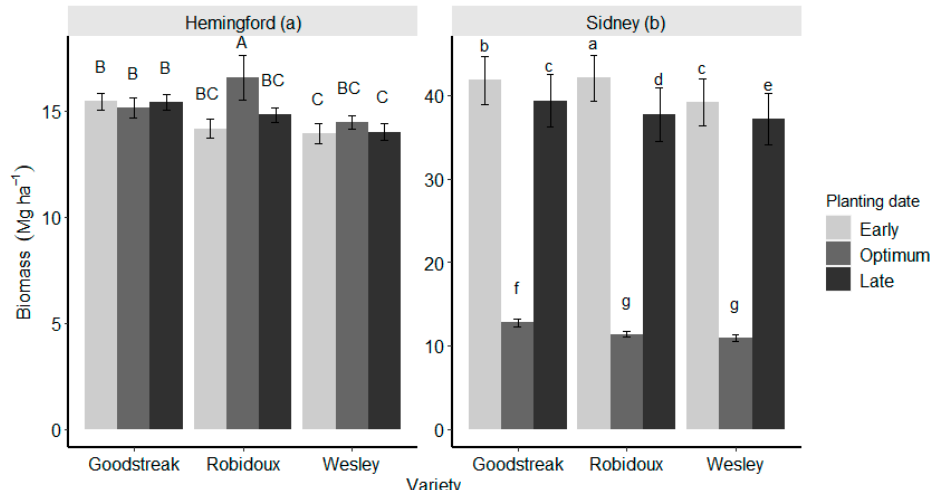
Figure 5. Influence of planting date × variety interaction on biomass at Hemingford and Sidney experimental sites. The error bars represent the standard error of the mean. Different letters on top of column bars of each panel indicate a significant mean difference at p < 0.05. Table 3. Means of main effects, showing significant differences where they exist using letters. Dif- ferent letters indicate a significant mean difference at p < 0.05. For those groups of means with no designation, the levels of the main effects performed similarly across the experiment.